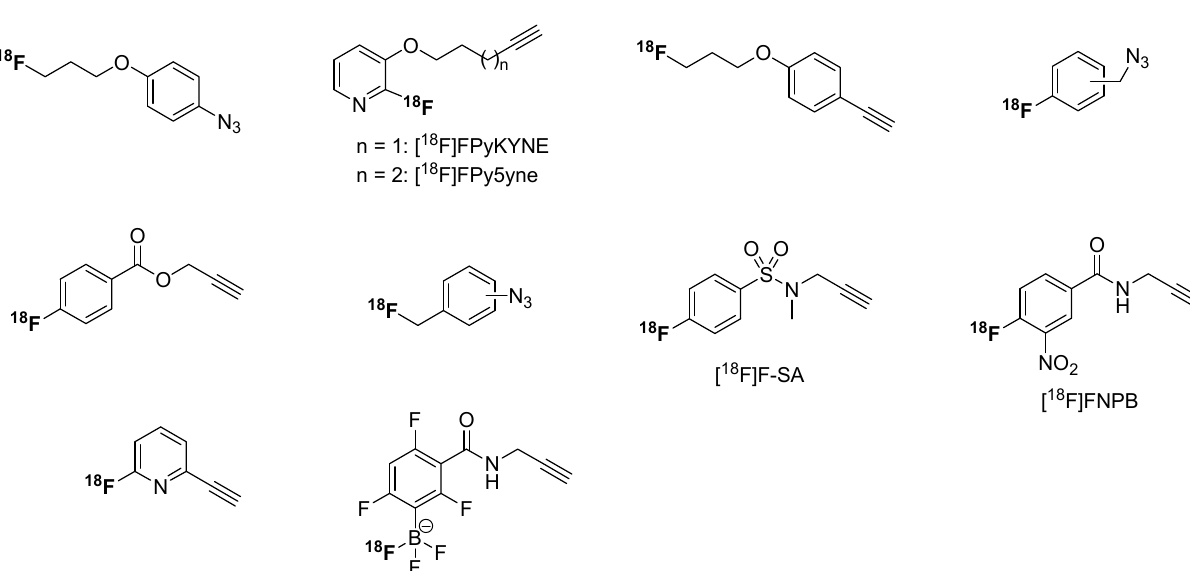
Scheme 20. Overview of [ 18 F]fluoroaryl building